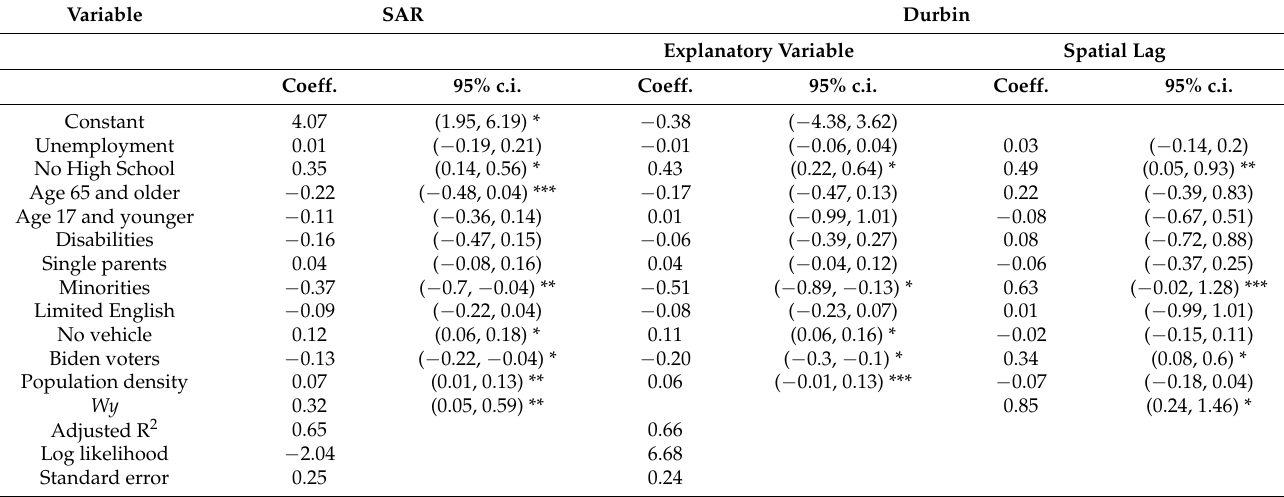
Table 4. Spatial regression